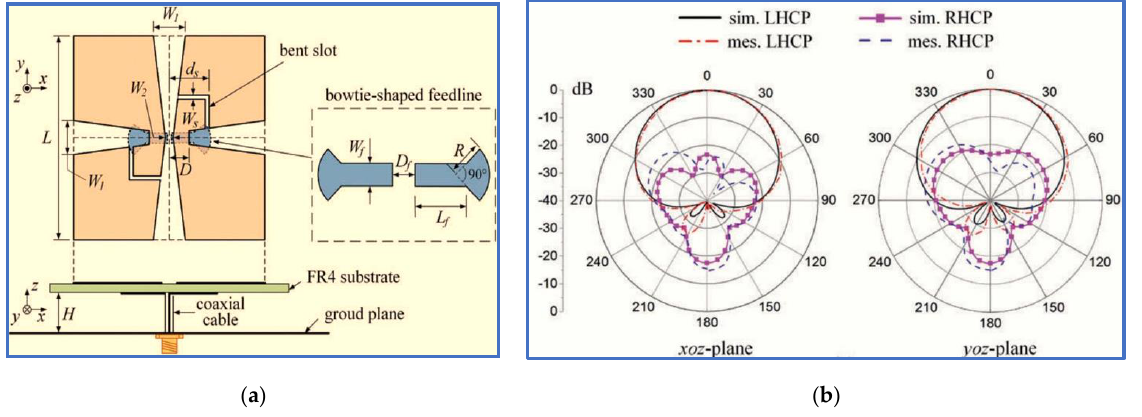
Figure 6. A proposed antenna: ( a ) antenna configuration and ( b ) radiation pattern at 2.0 GHz [15]. Conventional indoor antennas (waveguide, nonplanar or multilayer planar anten- nas) exhibit a wide or broad IBW, narrow ARBW, high gain and omnidirectional radiation pattern. However, they have a complicated design, bulky antenna size, high manufactur- ing cost and difficult design and fabrication. Hence, alternative antenna structures or tech- niques have been proposed to overcome these disadvantages. With the widespread interest in indoor antenna technology, designing indoor anten- nas with a planar structure has attracted growing attention. A microstrip or printed an- tenna offers several advantages, including compact size, low profile, simple design, easy fabrication and low production cost [57 – 59]. In addition to the recent requirements of in- building wireless communication systems, this type of antenna can provide circular po- larisation with an omnidirectional radiation pattern [60]. Conversely, traditional mi- crostrip printed antennas suffer from a narrow CP band (the ARBW is limited) and a dif- ficult trade-off between the achieved IBW and the antenna dimensions [60] and between the achieved omnidirectional radiation pattern with two circular polarisation senses (LHCP and RHCP) and the acceptable value of antenna gain [61 – 64]. 3. Microstrip Patch Antenna The microstrip patch antenna is the most widely used in recent wireless communica- tion systems particularly because of its attractive features, such as compact size, light weight and low cost [65 – 67]. The main contributing factor for microstrip antennas is the comfort and the easy integration with wireless communication systems [68]. In a mi- crostrip printed antenna, the feed line, radiator element and ground plane are printed on a printed circuit board. These antenna parts can be printed on two sides of the PCB (bi- planar geometry) or on one side of the PCB (uniplanar geometry). They are etched on a dielectric substrate with known material, dimensions and properties (loss tangent, dielec- tric constant and permittivity). Microstrip antennas can be also referred to as printed or patch antennas [69 – 71]. The radiator patch of a printed antenna can be rectangular, square, circular, elliptical, thin strip or any other configuration. Rectangular and circular microstrip patches are the most pop- ular configurations because of the ease of their analysis, design and fabrication. They also have attractive radiation characteristics, especially the radiation with low cross-polarisa- tion. Circular and linear polarisations can be realised with one or more arrays of mi- crostrip antennas [70]. The major drawbacks of microstrip antennas include the difficult trade-off between the achieved bands (IBW and ARBW) and their size, low efficiency and poor polarisation purity antennas [72,73]. Nevertheless, several methods can be used to improve antenna